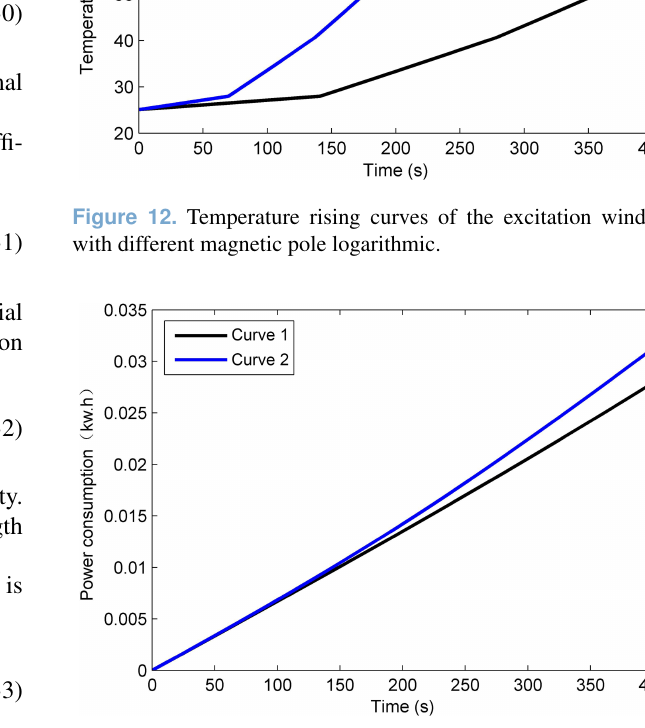
Figure 13. Energy consumption curves of electromagnetic brake under different magnetic pole